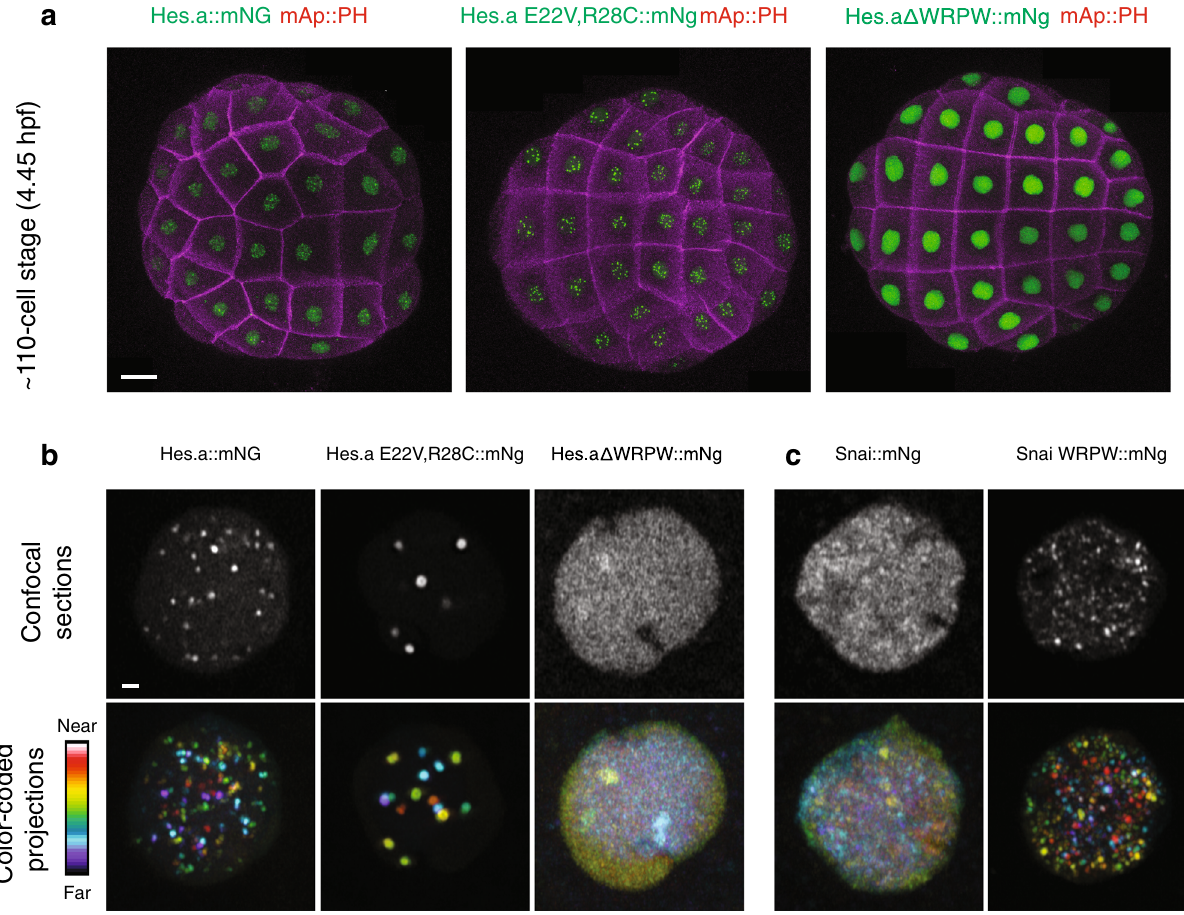
Fig. 2 The Hes.a repressor forms puncta in Ciona embryos dependent on DNA binding and the presence of a WRPW domain. a Maximum intensity confocal projections of ~110-cell stage embryos expressing Hes.a fusion proteins. Cell membranes are colored magenta and Hes.a::mNg fusion proteins are green. The embryos are oriented to show the animal hemisphere, anterior left. Scale bar = 20 μ m. b Confocal images of individual nuclei expressing Hes.a proteins fused to mNg. Single confocal sections are shown in white, color coded projections are shown with the indicated look up table. c Same as b but for the Snai::mNg. Scale bar = 1 μ m. All transgenes were expressed using pSP Sox1/2/3 > plasmids. All images are representative of >3 biological